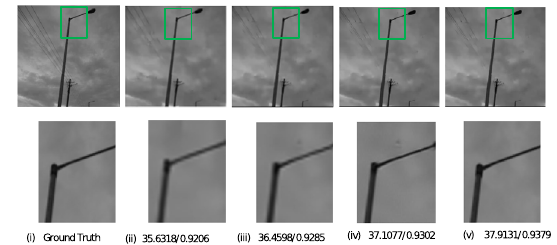
Figure 5. Result of enhancement on Sky image with PSNR and SSIM values (i) Ground Truth (ii) Degraded low resolution Image (iii) Result of conventional IBP enhancement technique (iv) Result of Edge preserving IBP (v) Result of the proposed method.